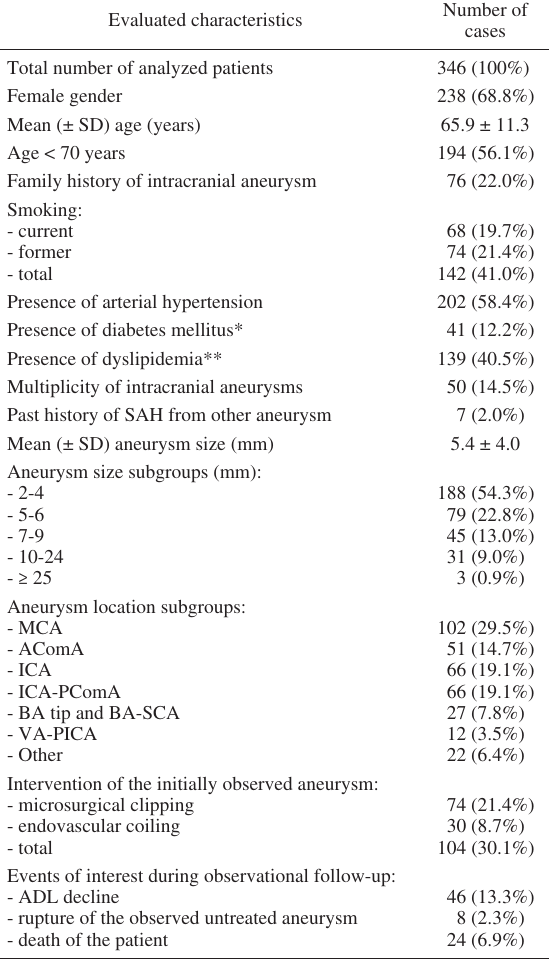
Table 1. Characteristics of the study